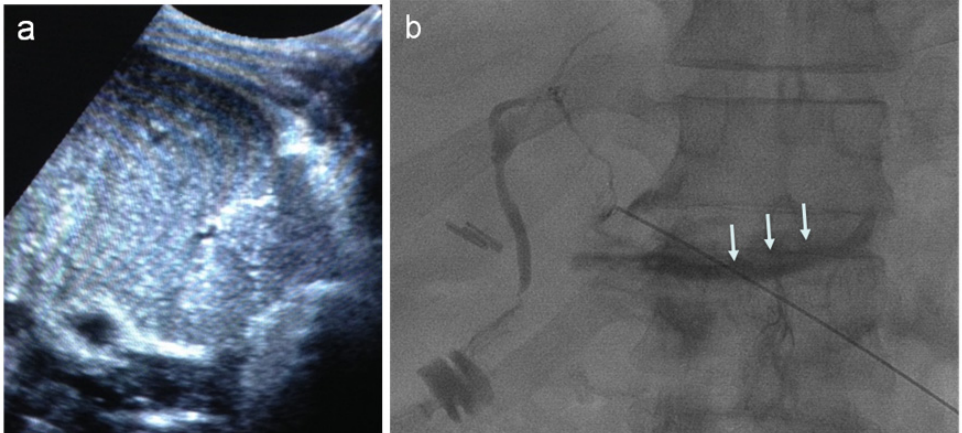
Figure 4. Biliary drainage using a left sub-xiphoid approach. ( a ) PTC performed through a puncture of a peripheral biliary duct of segment 3 in a patient with a biliary leak after pancreatic surgery. Biliary ducts are undilated and ultrasonically undetectable: anyway, the puncture is performed un- der US guidance parallel to the peripheral portal branch course to make the guidewire advancement in case of biliary tree opacification easier. ( b ) PTC demonstrating the extraluminal spreading of contrast material (arrows) due to a biliary leak.